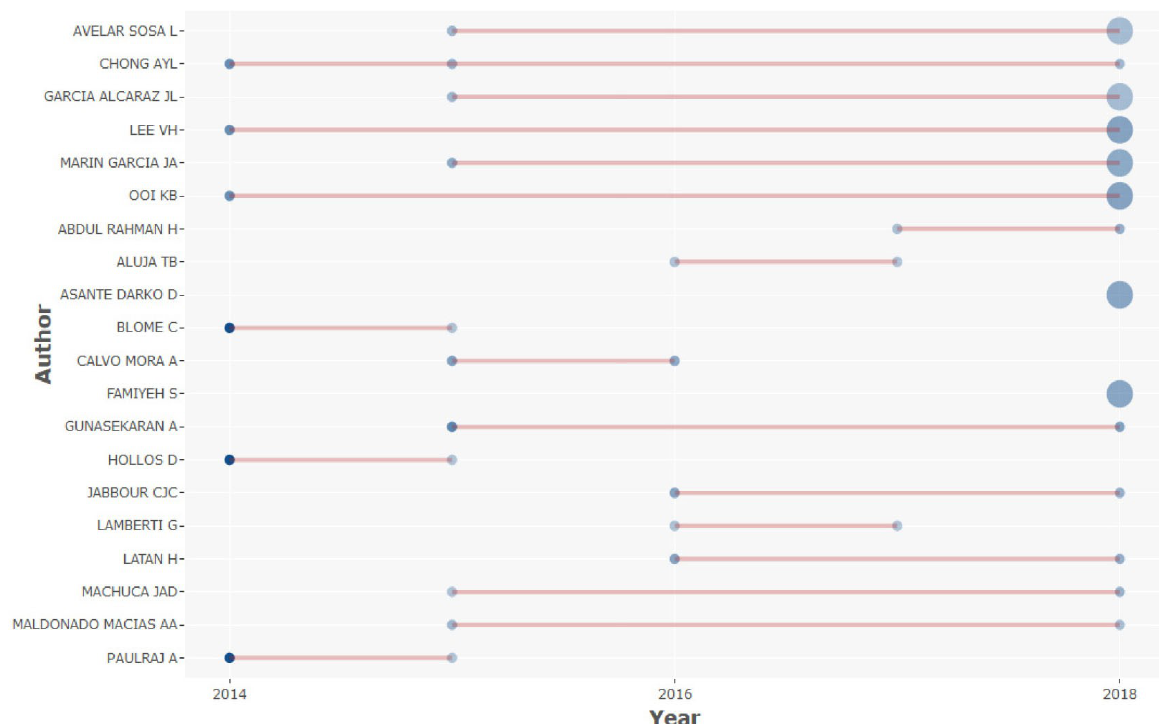
Figure 3. Top-Authors’ production over